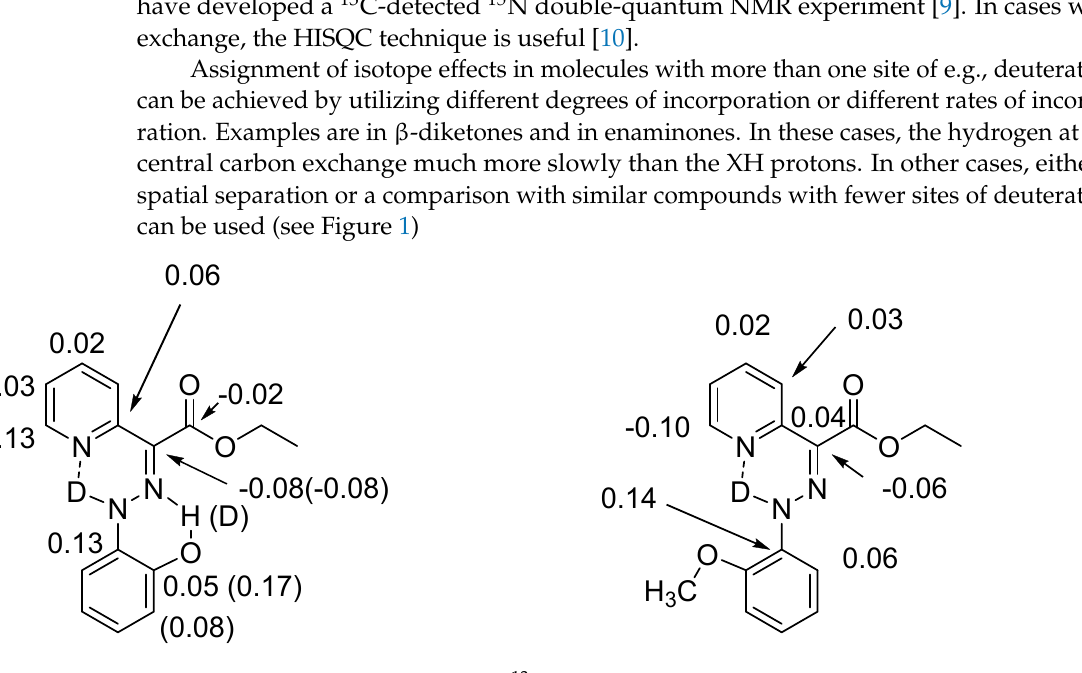
Figure 1. Deuterium isotope effects on 13 C chemical shifts. Values in brackets are due to the deuterium in brackets. Data from Ref. [11].